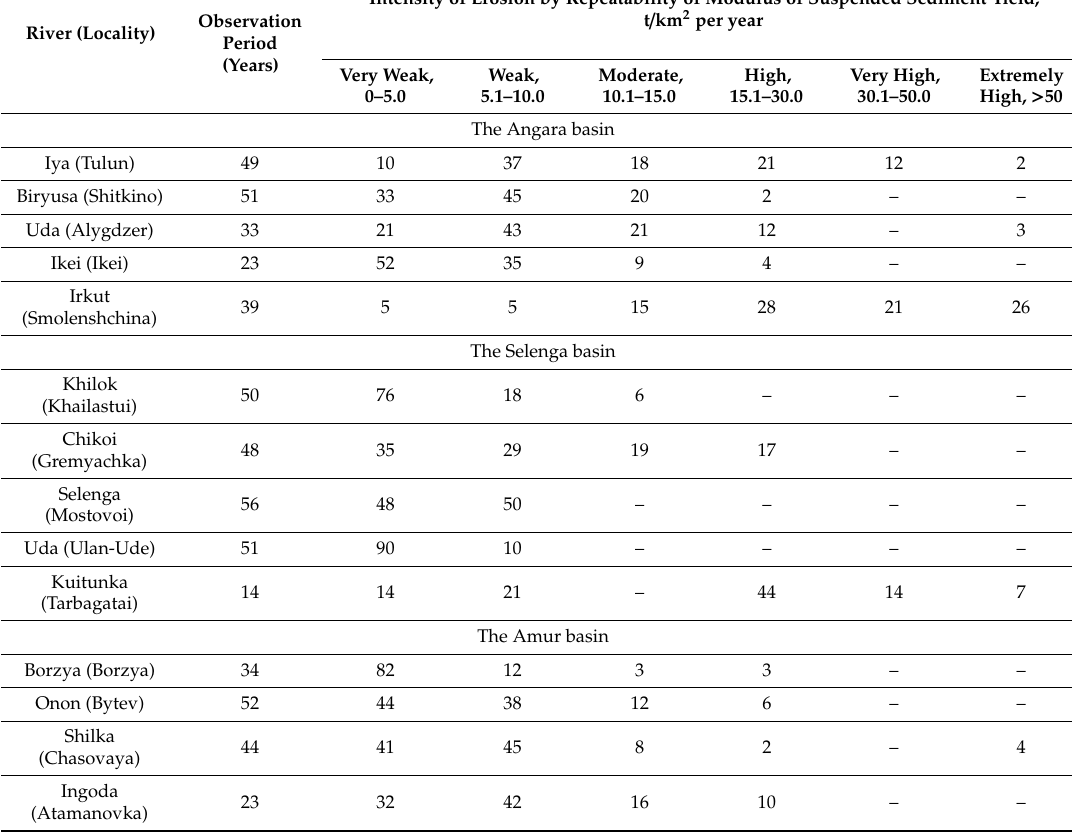
Table 4. The probability of the erosion process development of various intensities in the south of Siberia,